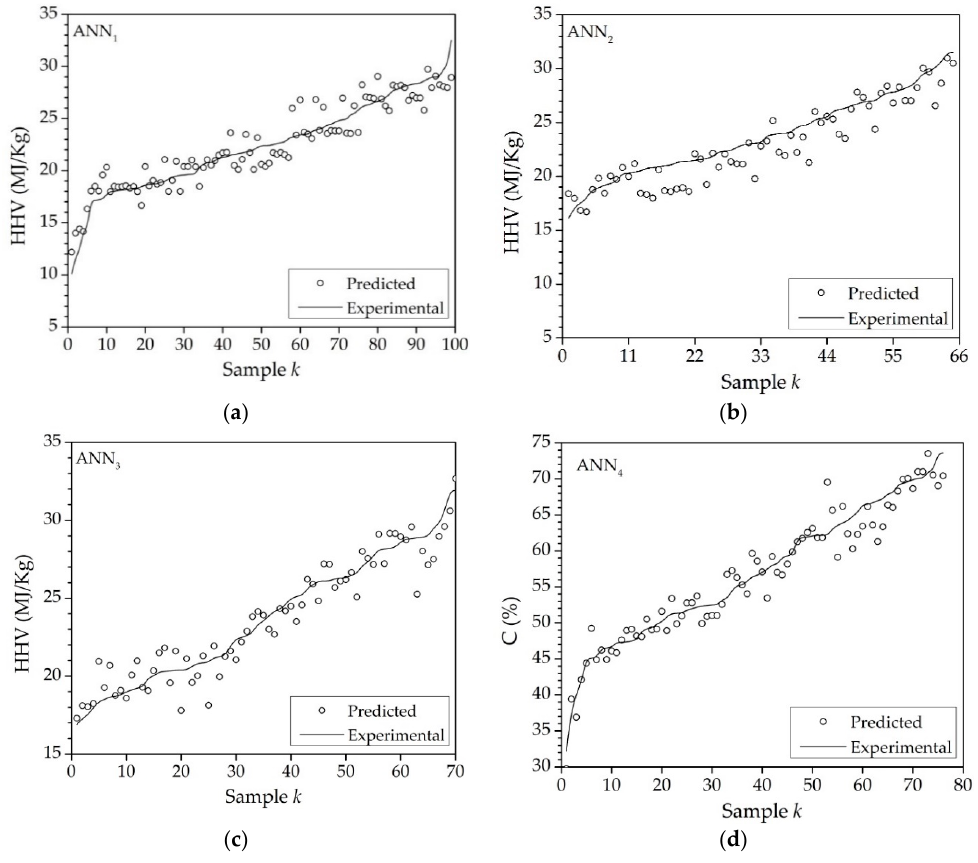
Figure 4. Experimental, te k HHV or te k C , and predicted, pr k HHV or pr k C from ( a ) ANN 1 , ( b ) ANN 2 , ( c ) ANN 3 , and ( d ) ANN 4 output biochar values.